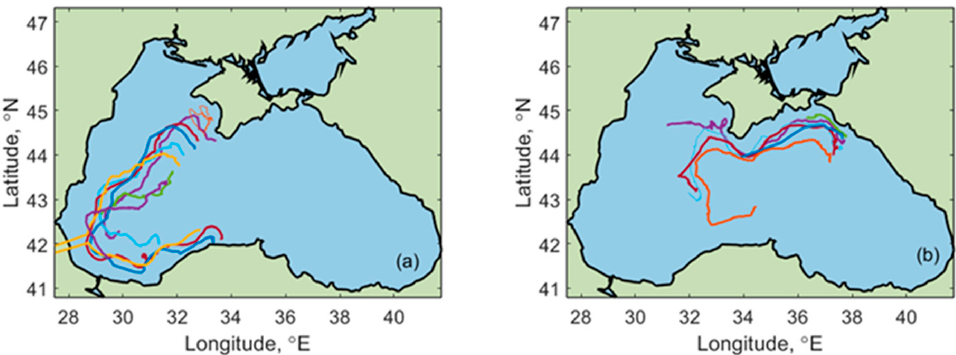
Figure 1. Trajectories of seven drifters #16330–#16337 ( a ) and six drifters #33347-#33351 ( b ) deployed in the Black Sea.